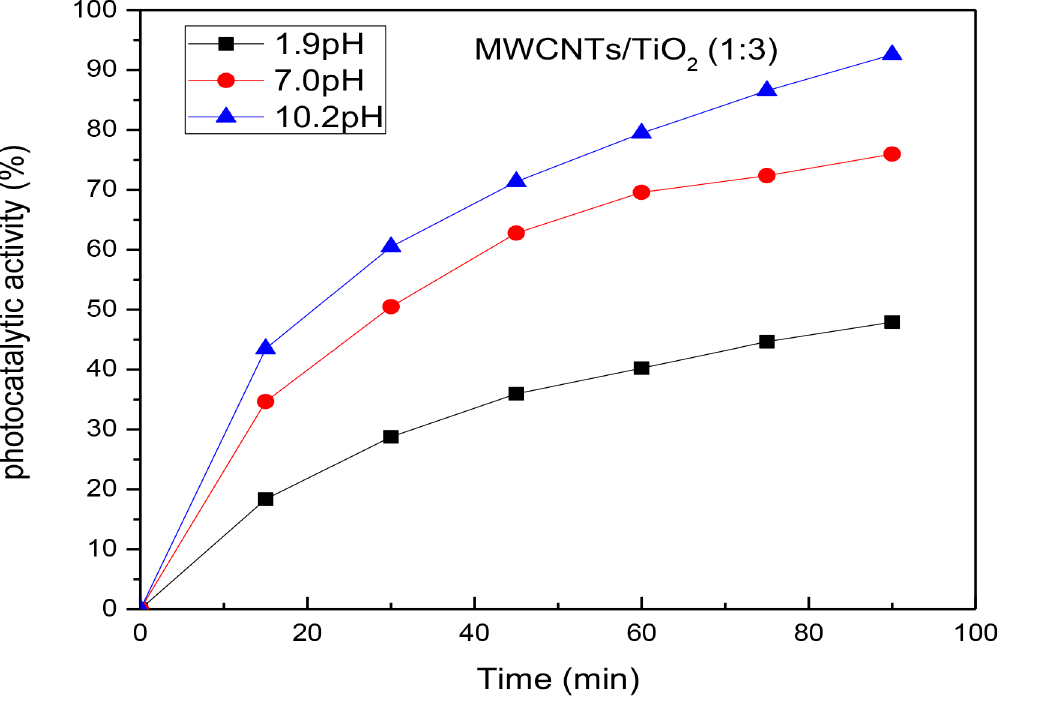
Fig 8. The influence of pH on the photoactivity of the MWCNTs/TiO 2 (1:3) catalyst.